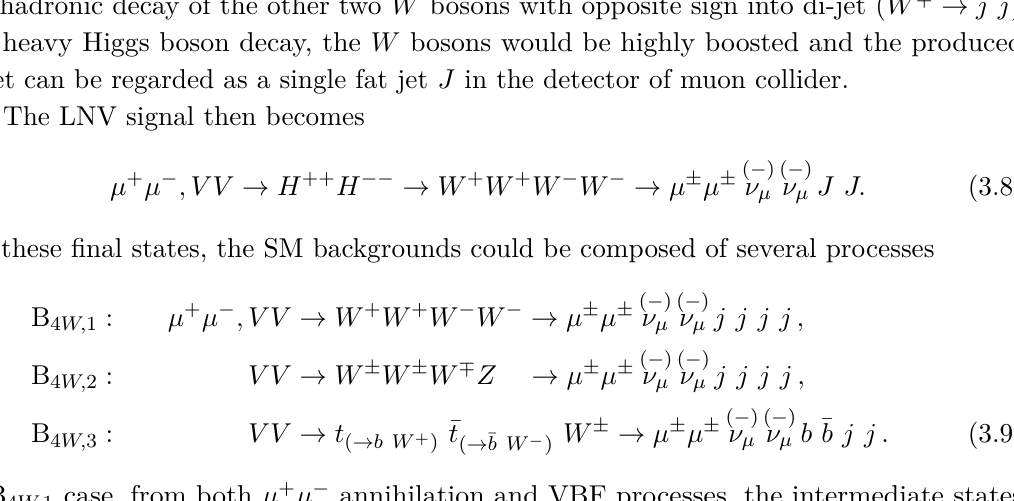
Figure 11 . The integrated luminosities required for 2 σ (solid lines) and 5 σ (dashed lines) significance versus m for H ++ H −− → µ + µ + µ − µ − at muon colliders with H ±± in neutrino mass pattern NH (red) or IH